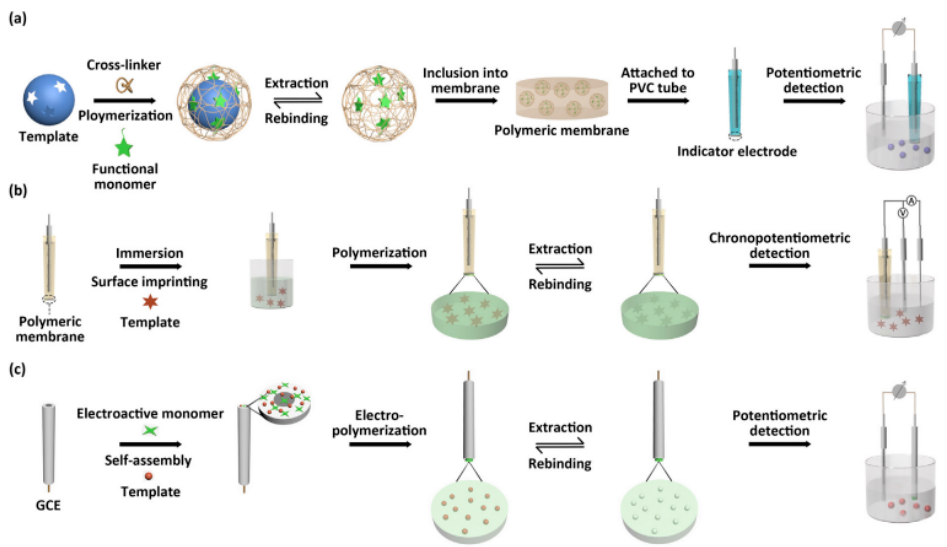
Figure 7. Typical manufacturing of MIP potentiometric sensors with polymeric membranes, through three processes: MIP incorporation ( a ), MIP covering ( b ), and MIP electropolymerized ( c ). Reprinted with permission from [42].